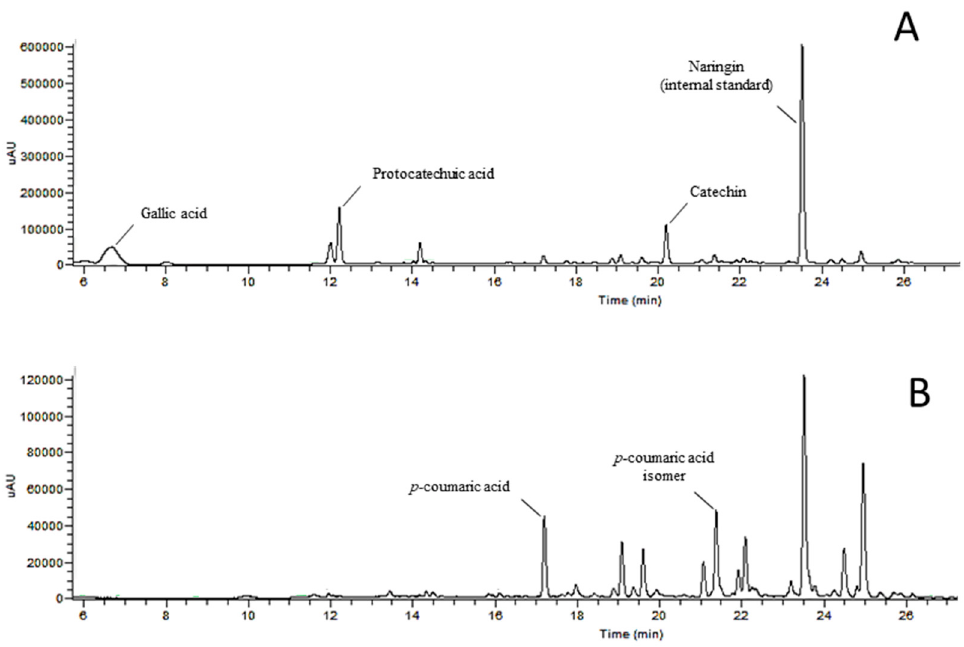
Figure 4. Example of a HPLC chromatograms of phenols detected in sweet cherry kernel’s extracts, recorded at different wavelengths: 280 nm ( A ) and 320 nm ( B ).